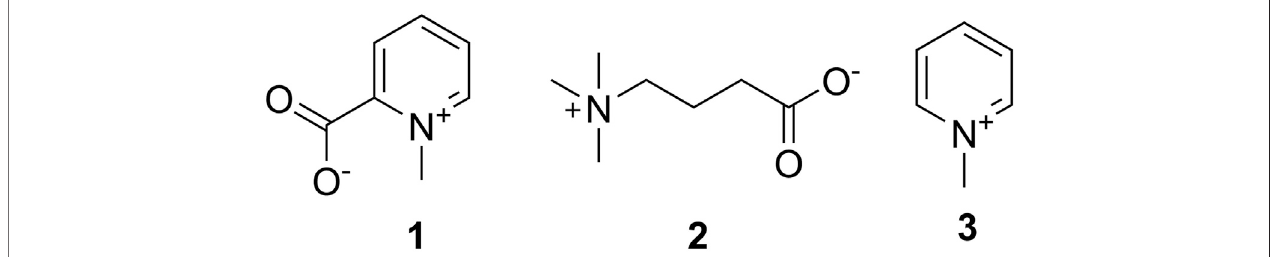
FIGURE3| Firstsmallmoleculesidenti fi edinconesnails.ThesecompoundswerefoundbyKohnin1960in C . textile , C . striatus ; 1 wasidenti fi edin C . litteratus , C . marmoreus , and C . magus .